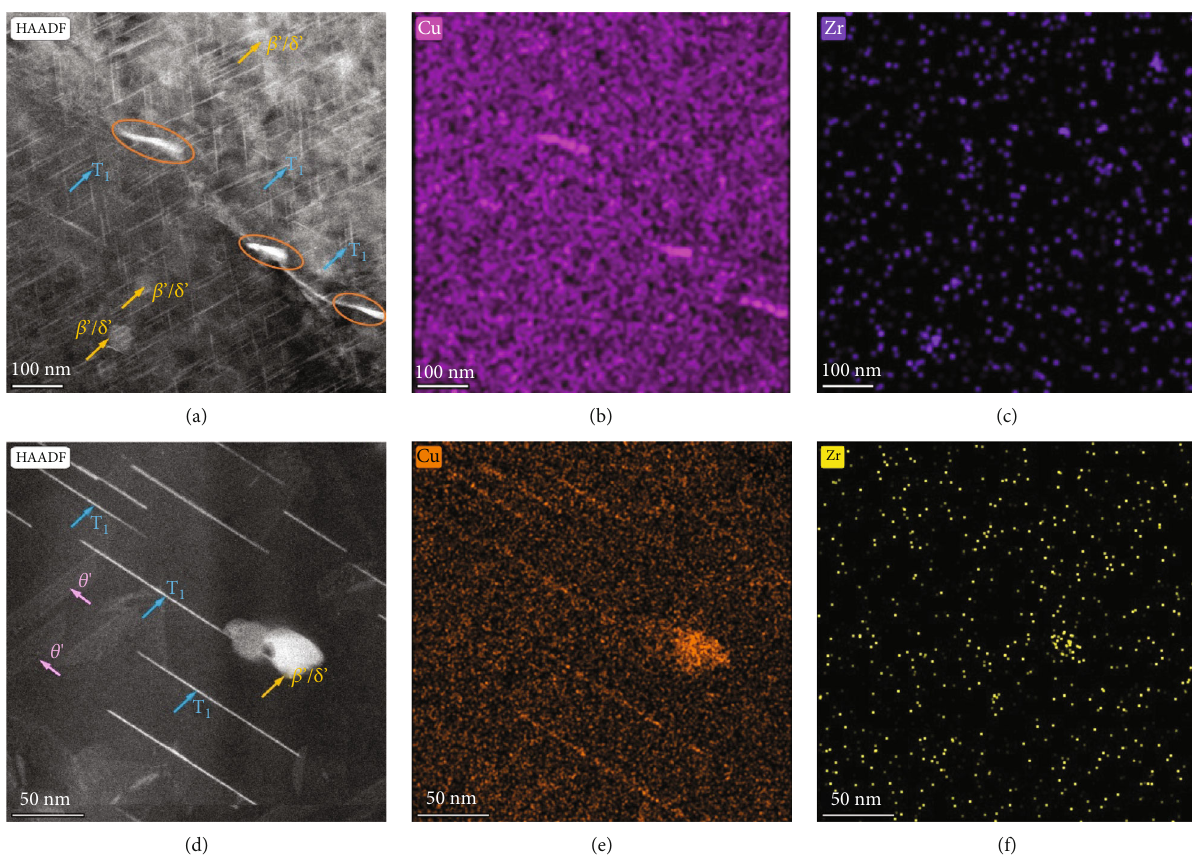
Figure 4: TEM micrographs of 2195-T8 alloy: (a) gain boundary region; (b), (c) Cu and Zr distribution in (a); (d) inner grain region; (e), (f) Cu and Zr distribution in (d),